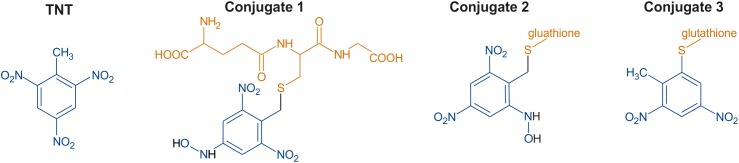
Chemical structures of 2,4,6-trinitrotoluene (TNT) and the three glutathione-TNT conjugates, as determined by Gunning et al. (2014).